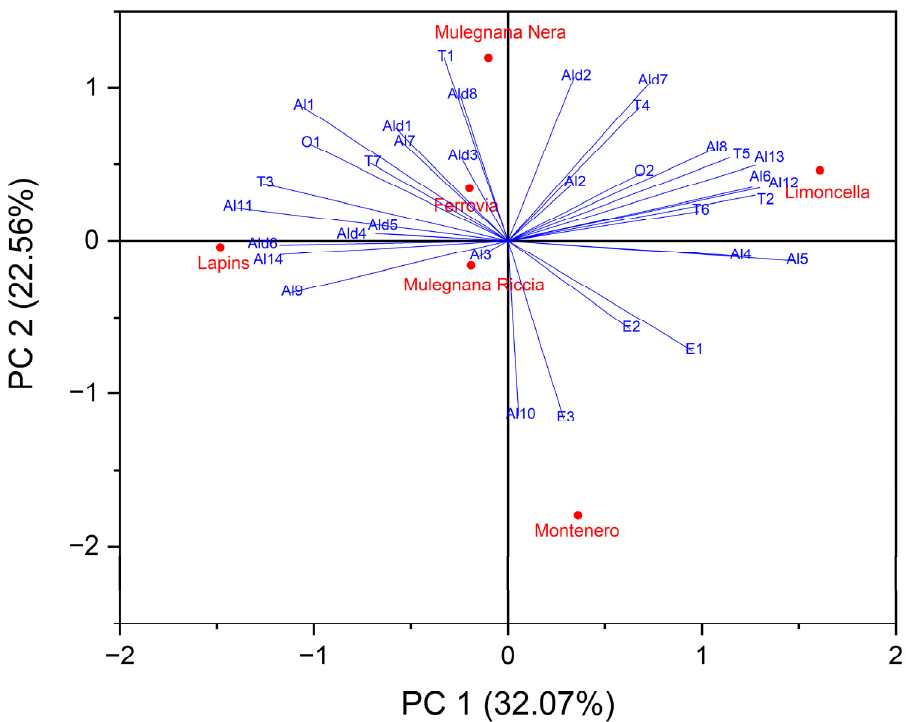
Figure 6. Biplot of volatile organic compounds in the four sweet cherry accessions (Mulegnana Riccia, Mulegnana Nera, Montenero and Limoncella) compared to two standard cultivars (Lapins and Ferrovia).